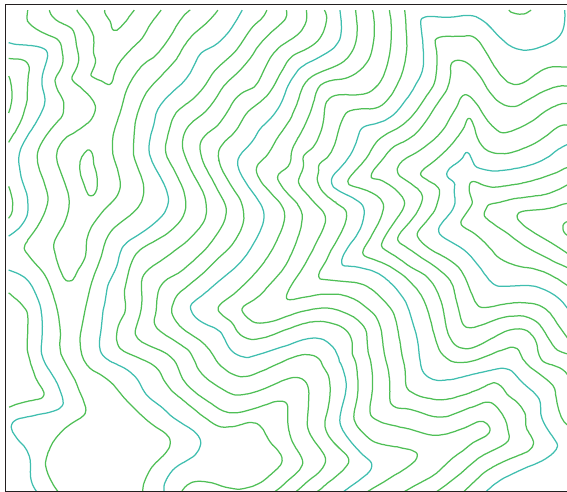
Figure 1: Original CAD contour map.